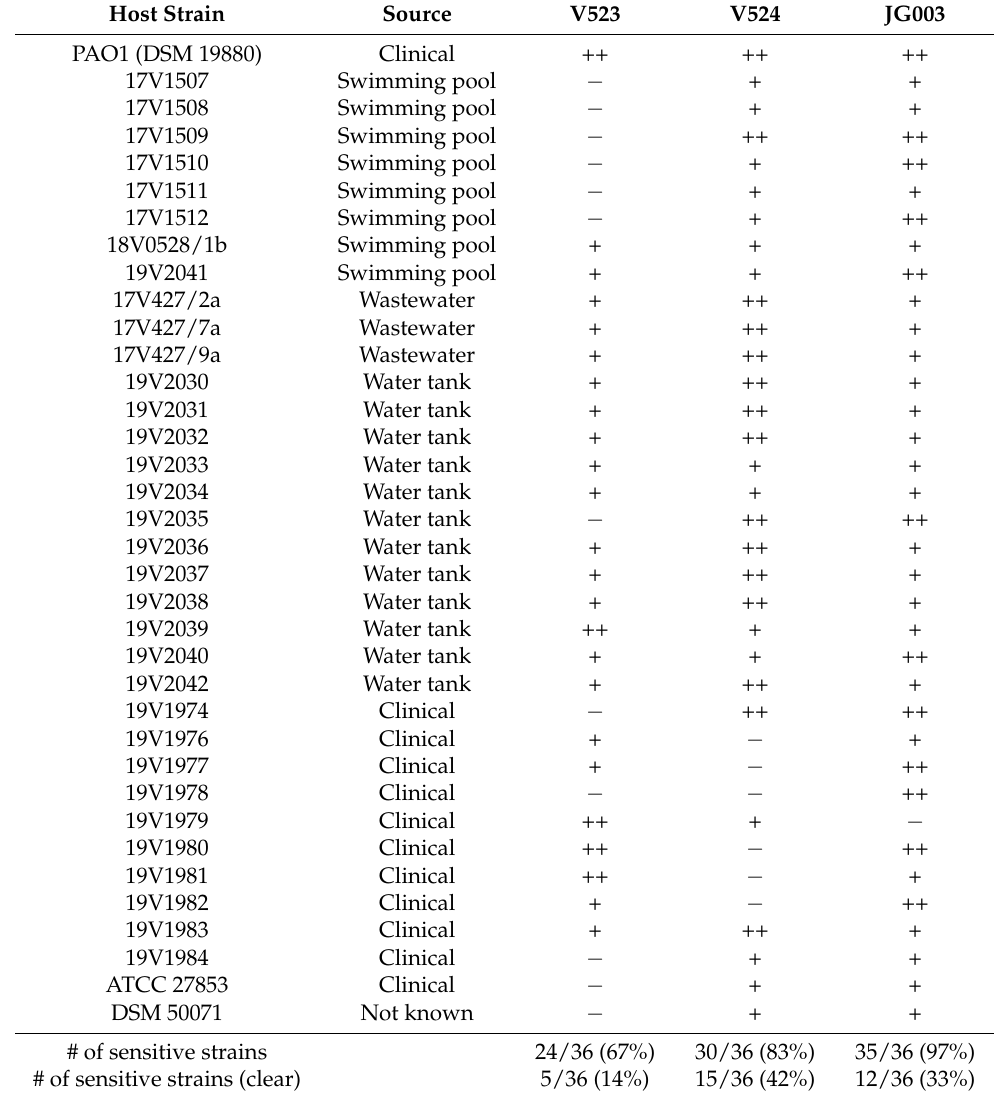
Table 2. Host range of individual phages V523, V524 and